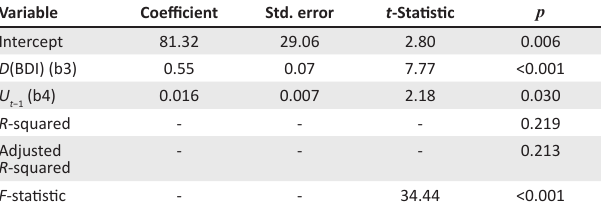
TABLE 4: Results of error-correction model using first difference for All Share Index and Baltic Dry Index for estimation of short- and long-run disequilibrium